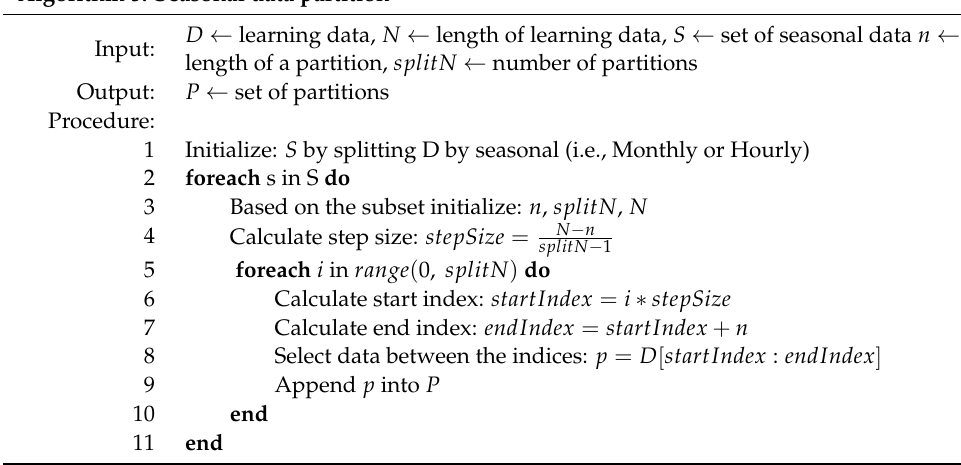
Algorithm 5. Seasonal data partition